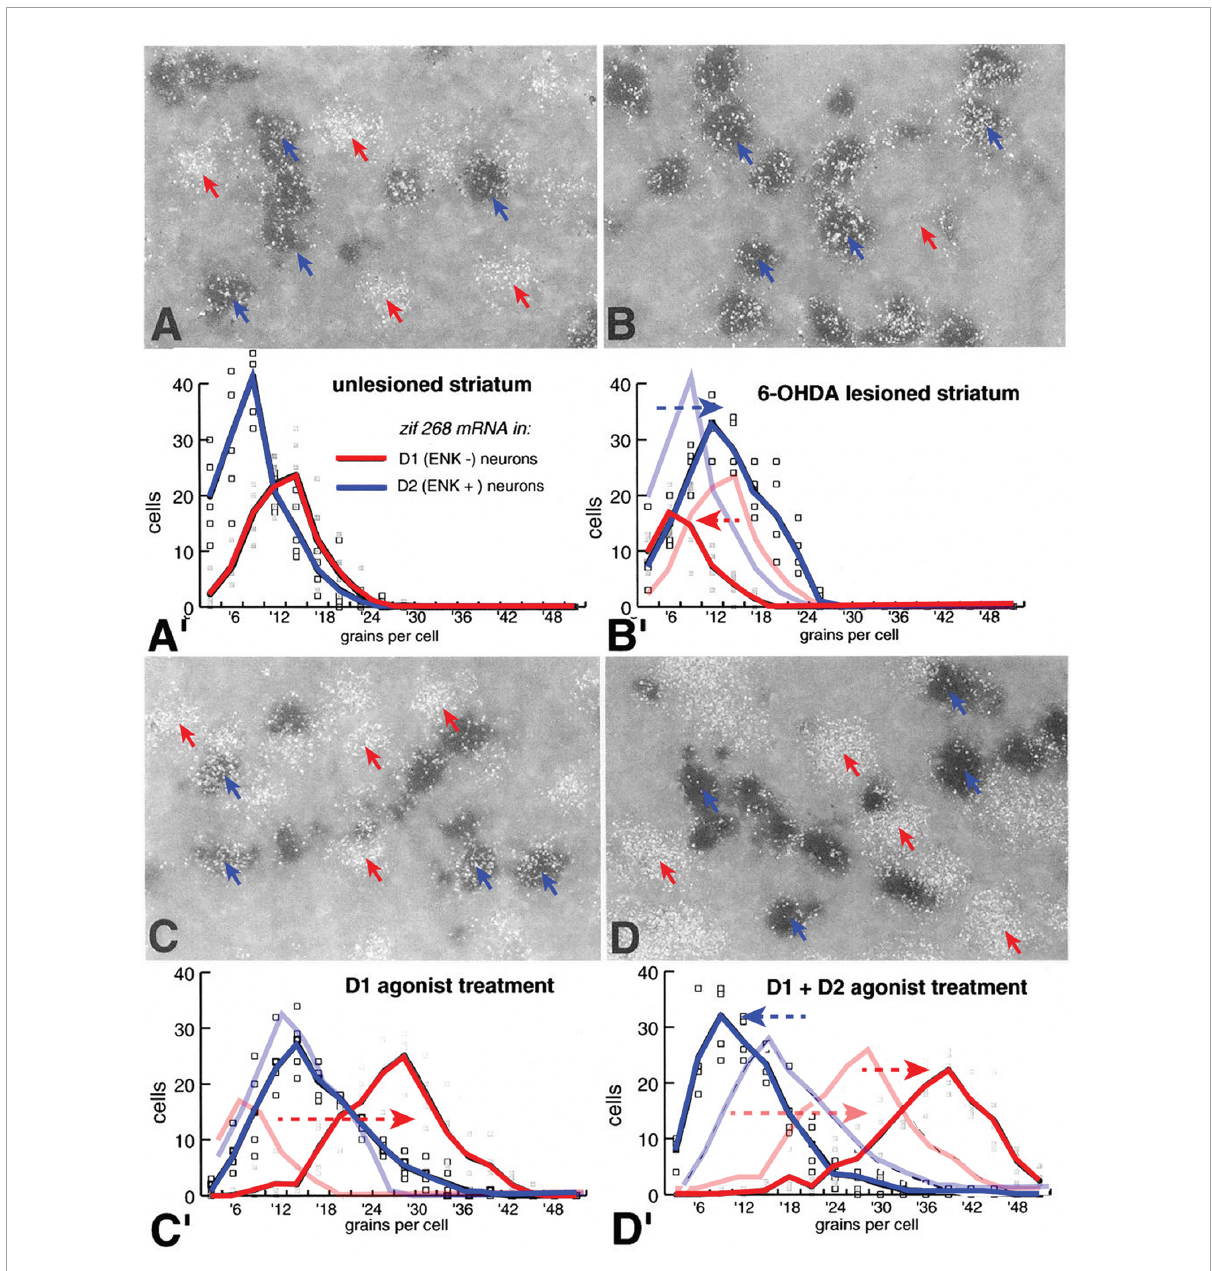
FIGURE3 Expression of the IEG, zif268 (egr2) in D1r- and D2r-neurons in the control dopamine intact striatum (A) , in the dopamine-depleted 6-OHDA lesioned striatum (B) , in the lesioned striatum of animals treated with a D1r-selective agonist (C) and in the lesioned striatum of animals treated with both a D1r- and D2r-selective agonists (D) . Expression of zif268 is determined by the number of silver grains (white) generated with 35S-oligonucleotide labeling of zif268 mRNA concentrated over striatal neurons labeled with alkaline-phosphatase labeled ribonucleotide probes for ENK (blue arrows) or over putative D1r expressing neurons that do not express ENK (red arrows). Histogram distribution of the average number of zif268_ISHH generated silver grains per ENK+ (D2) and ENK– (D1) cells from five animals are plotted for each condition. In the unlesioned striatum there is no significant difference in zif268 levels between D1 and D2 cells (A’) . In the 6-OHDA lesioned striatum there is a significant increase in D2 cells and decrease in D1 cells (B’) compared to levels in the dopamine intact striatum (distributions from panel A’ are shaded in panel B’ ). In animals with 6-OHDA lesions to deplete striatal dopamine that were treated with a D1r selective agonist (SKF38393, 1.0 mg/kg i.p.), there is no significant change in zif268 levels in D2 cells but a significant increase in D1 cells (C’) compared to levels in the dopamine depleted striatum without agonist treatment (distributions from panel B’ are shown shaded in panel C’ ). Treatment with combined D1r-agonist (SKF38393, 1.0 mg/kg i.p.) and D2r-agonist (quinpirole, 1.0 mg/kg) resulted in a reduction in zif268 levels in D2-cells and a significant increase in D1-cells compared to levels compared with levels in the lesioned striatum of animals treated with the D1r-agoinist alone (distribution levels from panel C’ are shaded in panel D’ ). These data demonstrate that D1r- and D2r-selective agonists have opposite acute effects on dSPN and iSPNs (Gerfen et al.,